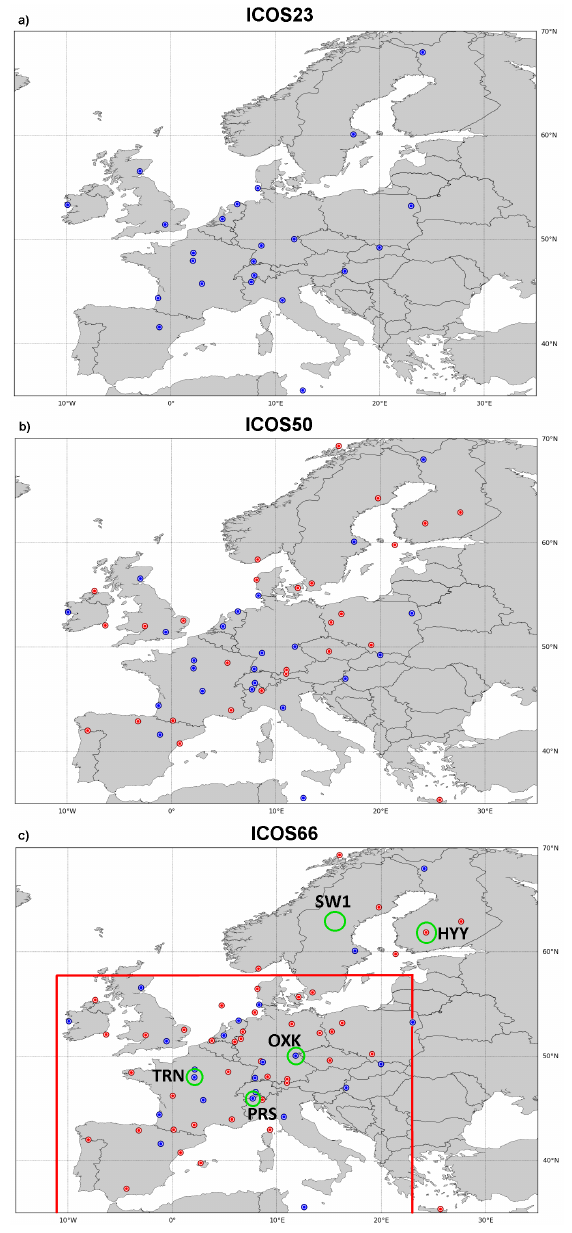
Figure 1. Site location for the different ICOS network configura- tions used in this study: (a) ICOS23, (b) and ICOS50 (c) ICOS66. Dark blue circles correspond to ICOS23 and the red circles are the new sites for ICOS50 and ICOS66 compared to ICOS23. The European domain ( ∼ 6 . 8 × 10 6 km 2 of land surface) covered by these figures corresponds to the domain of the configuration of the CHIMERE atmospheric transport model used in this study. The red rectangle in panel (c) corresponds to a western European do- main (WE domain, ∼ 3 . 5 × 10 6 km 2 of land surface), which is used for some of the present analysis because it is significantly better sampled by the ICOS networks than other areas. Green circles in panel (c) are the station locations used for the study of the uncer- tainty reduction as a function of the spatial scale of the aggregation around each station (in Sect.